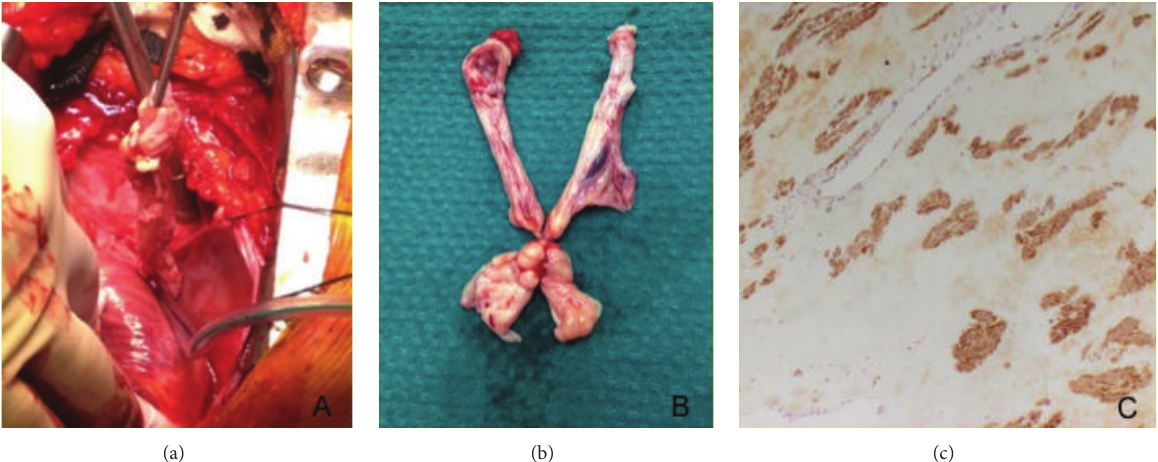
Figure 3: (a) A thin, white mass in the RA with its attachment extending down the IVC and (b) the gross specimen of the intracardiac tumor. (c) Smooth muscle actin antibody stain positive in the tumor